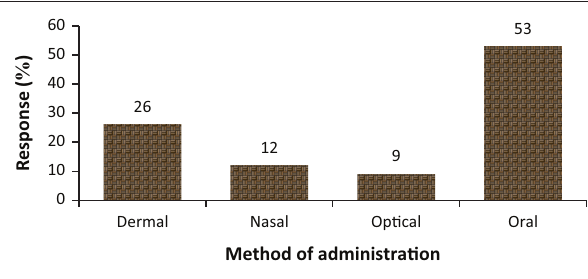
FIGURE 5: Mode of administration of the herbal